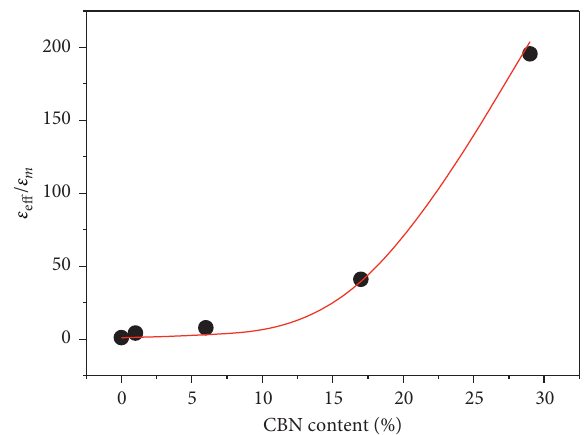
Figure 4: Dielectric constant vs. concentration at a frequency of 1kHz for systems based on the epoxy matrix and CBN. The solid red line is the percolation model (equation